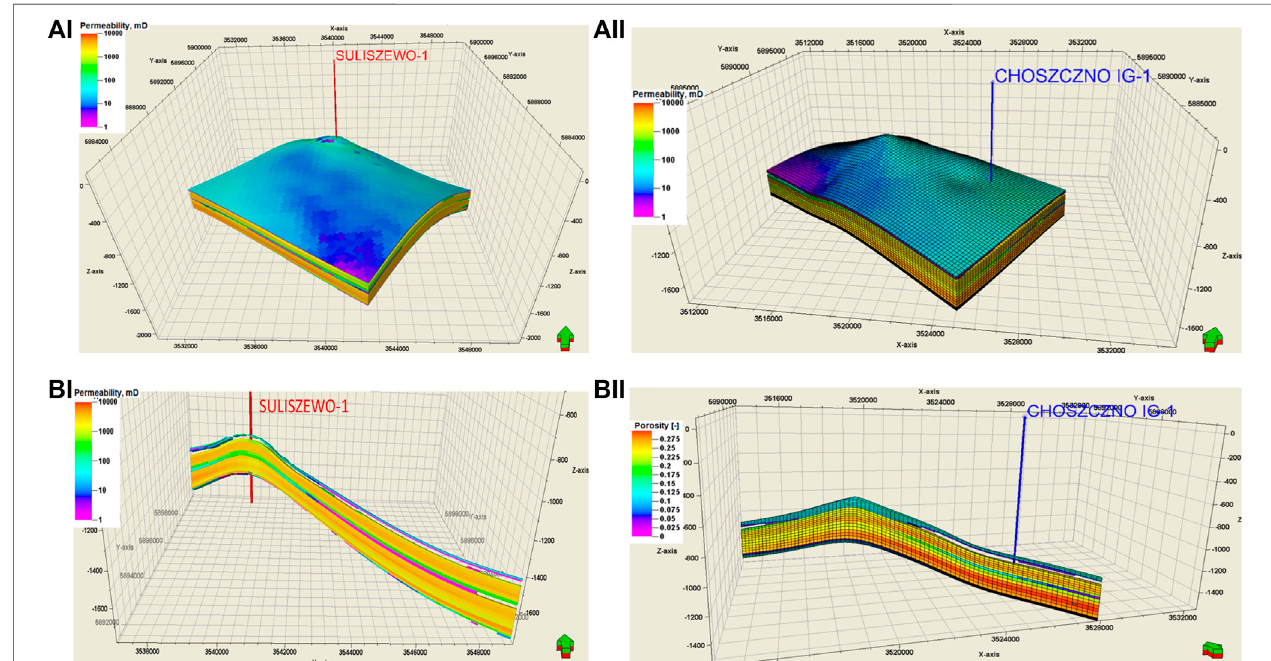
FIGURE2| Numericalmodelinthe (I) Suliszewo-1and (II) ChoszcznoIG-1wellarea: (A) Permeabilitymodel, (B) hydrodynamicdiscontinuityintheporositymodel.